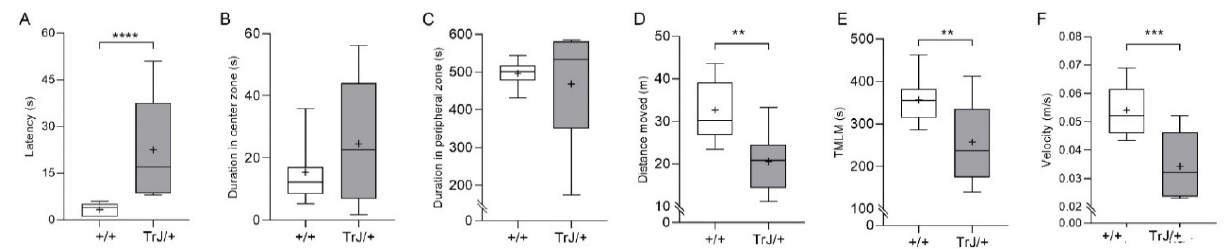
Figure 1. Movement parameters of +/+ mice and TrJ/+ mice in the open field test. ( A ) Latency. ( B ) Duration in the center zone. ( C ) Duration in the peripheral zone. ( D ) Distance moved. ( E ) TMLM: time during which the mice were making locomotion movement. ( F ) Velocity. Parameters in ( A – C ) were not parametrically distributed and they were analyzed using the Mann–Whitney U-test. Parameters in ( D – F ) were normally distributed and analyzed using Student’s t -test, df = 18. Asterisk indicates a significant difference between TrJ/+ (gray bars, n = 9) and +/+ (white bars, n = 11). ** p < 0.01, *** p < 0.001, **** p < 0.0001. The mean is shown as “+”.